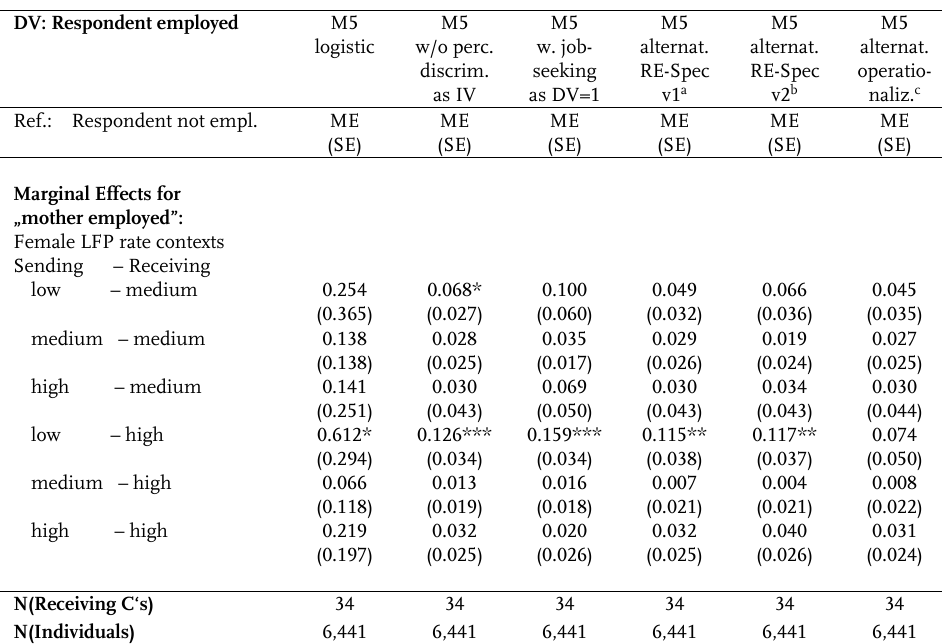
Table A.6 : Marginal effects for robustness-check